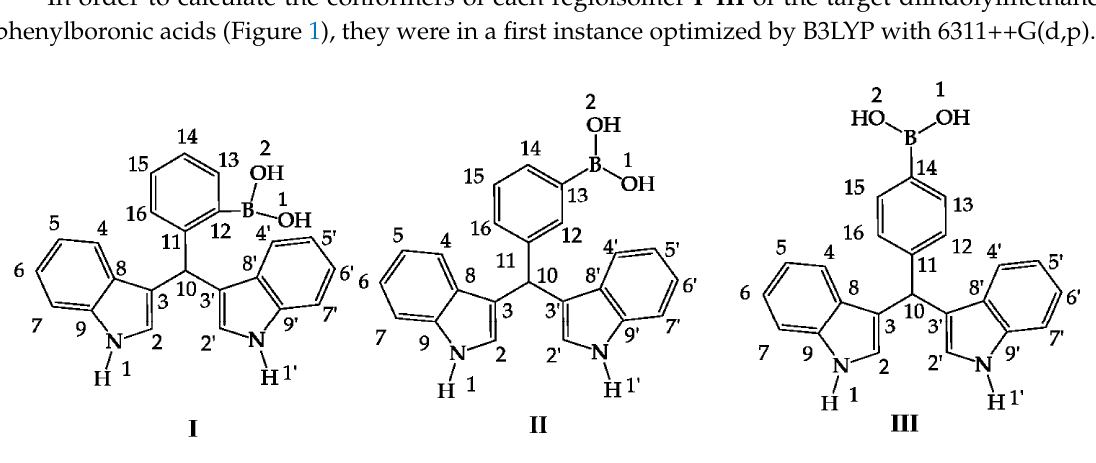
Figure 1. Hybrid diindolylmethane phenylboronic acid regioisomers: ortho ( I ), meta ( II ) and para ( III ).